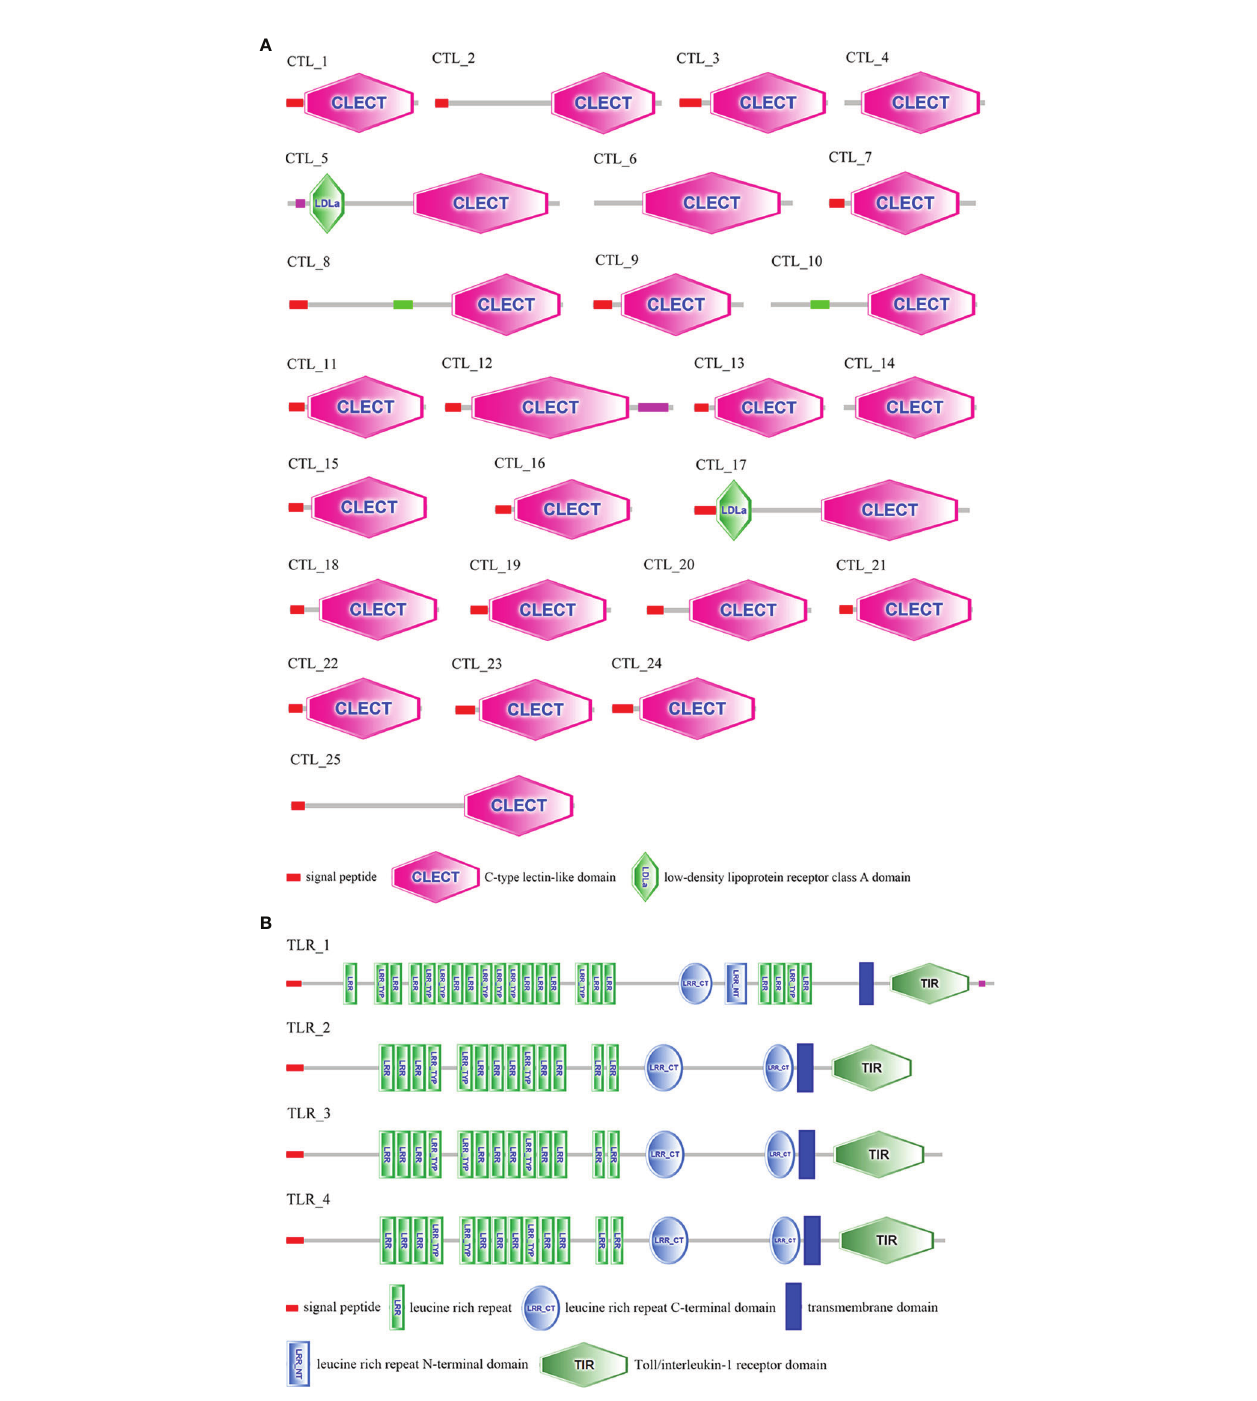
FIGURE 3 | Domain architecture of CTLs (A) and TLRs (B) predicted by SMART. The sequences and transcript IDs are listed in Supplementary File 5 and Supplementary File 6